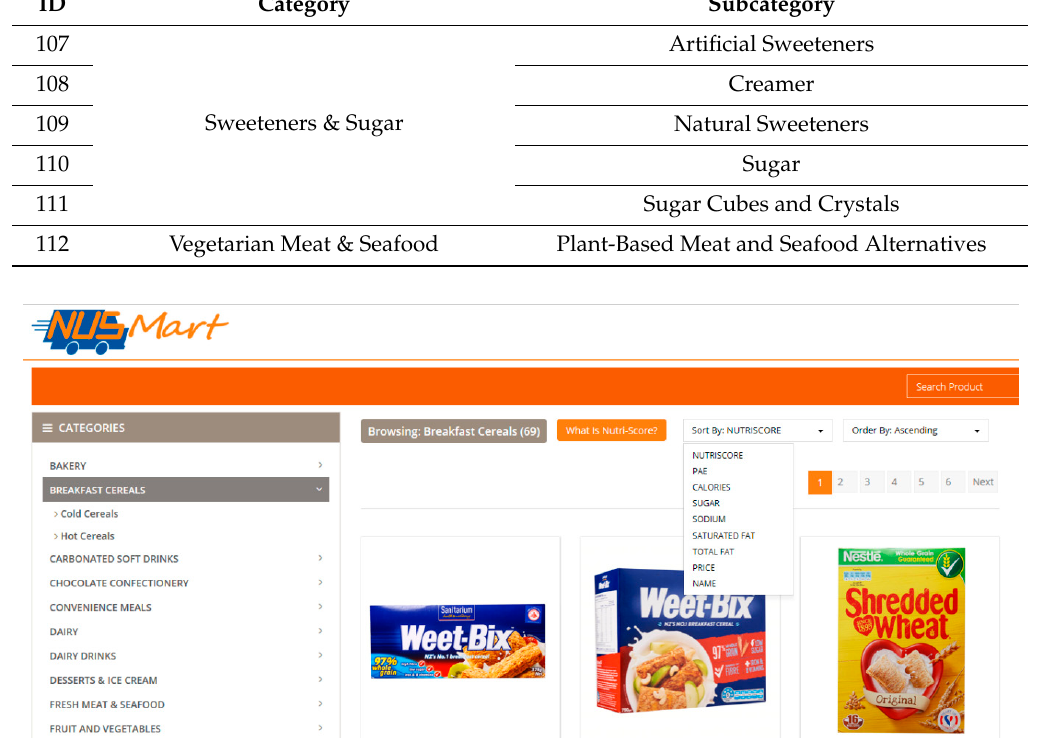
Figure A1. A screenshot of the product-reordering function by food labels. Note: The default food label was Nutri-Score.